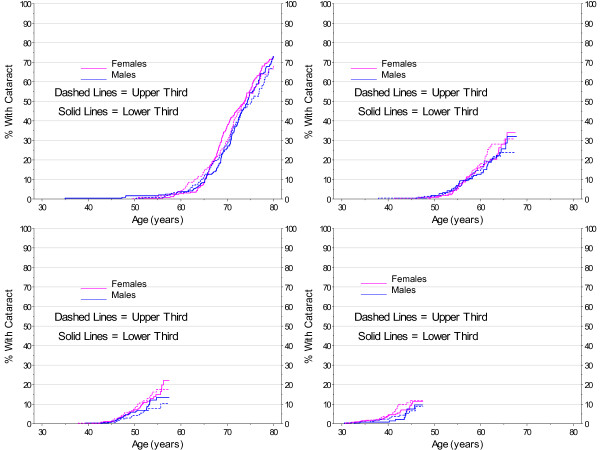
Kaplan-Meier Estimates for Cataract Incidence by HDL (lower vs. upper third), Gender, and Birth Cohort with No Diabetes.